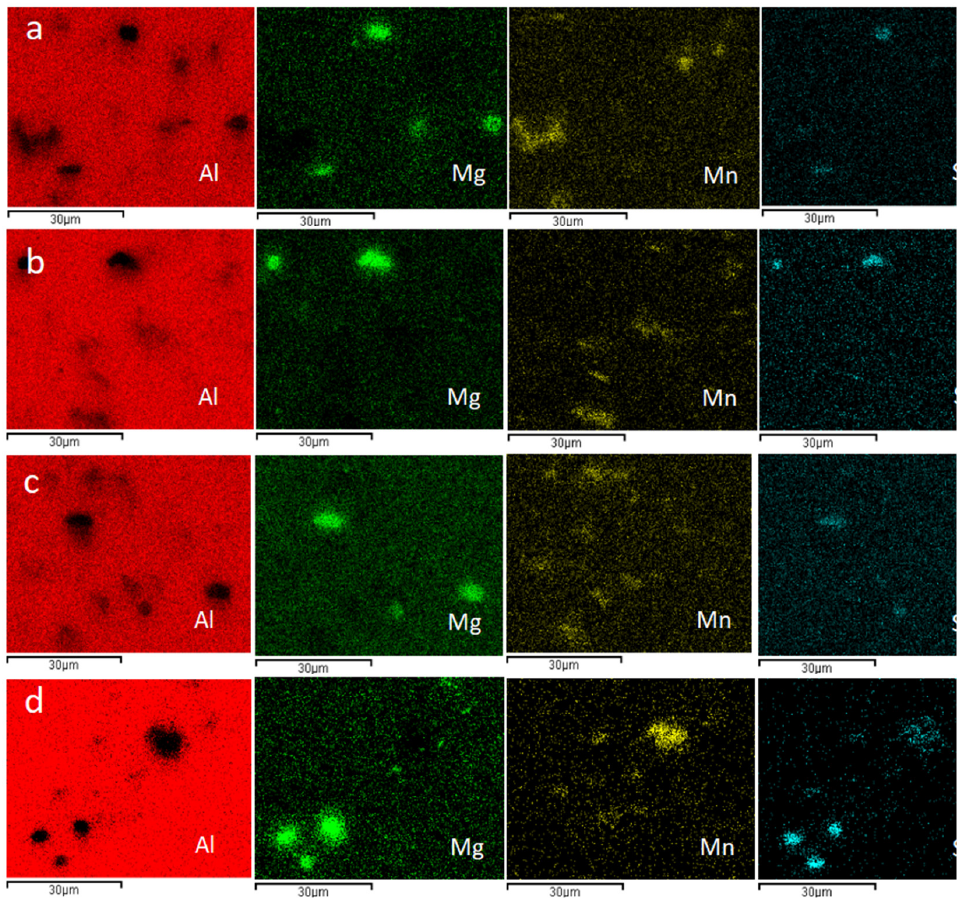
Figure 3. Element surface scanning ( a ) 663.15 K, 0.001 S −1 , ( b ) 663.15 K, 10 S −1 , ( c ) 713.15 K, 1 S −1 , ( d ) 763.15 K, 1 S −1 .